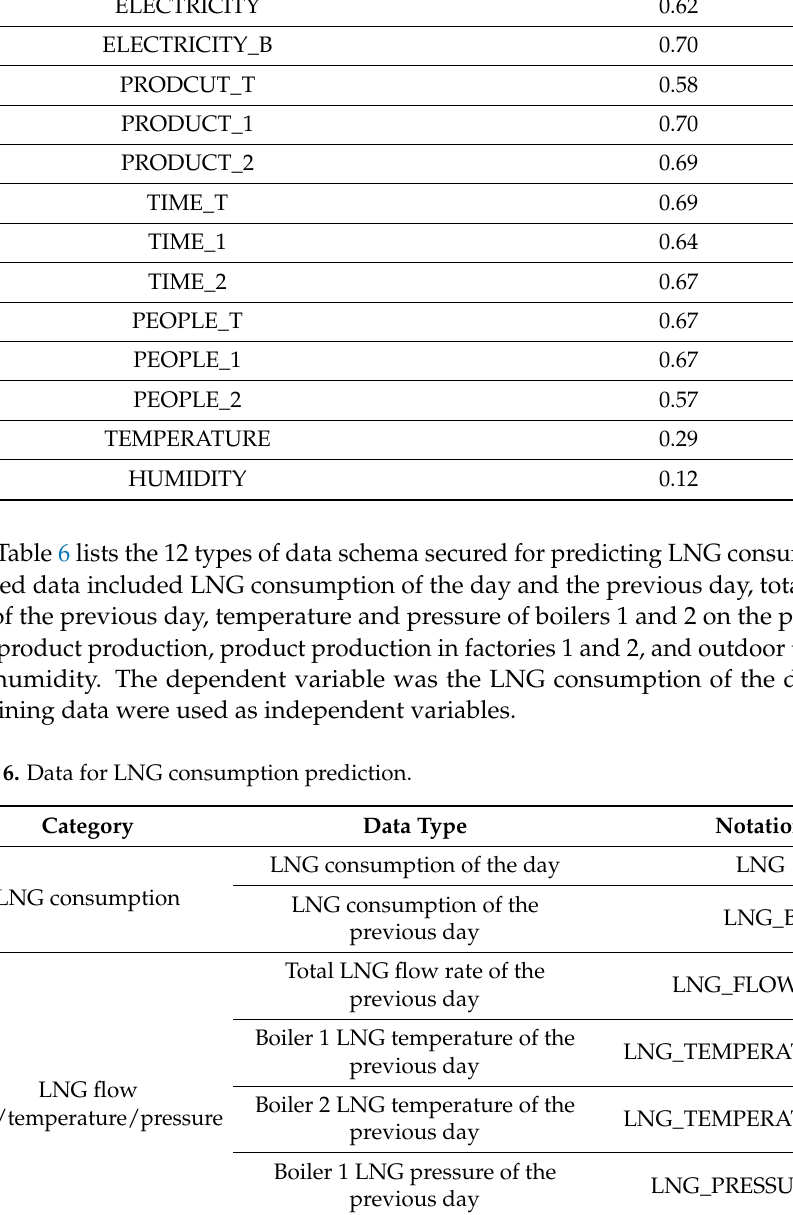
Table 5. Correlations with the electricity consumption of the day.